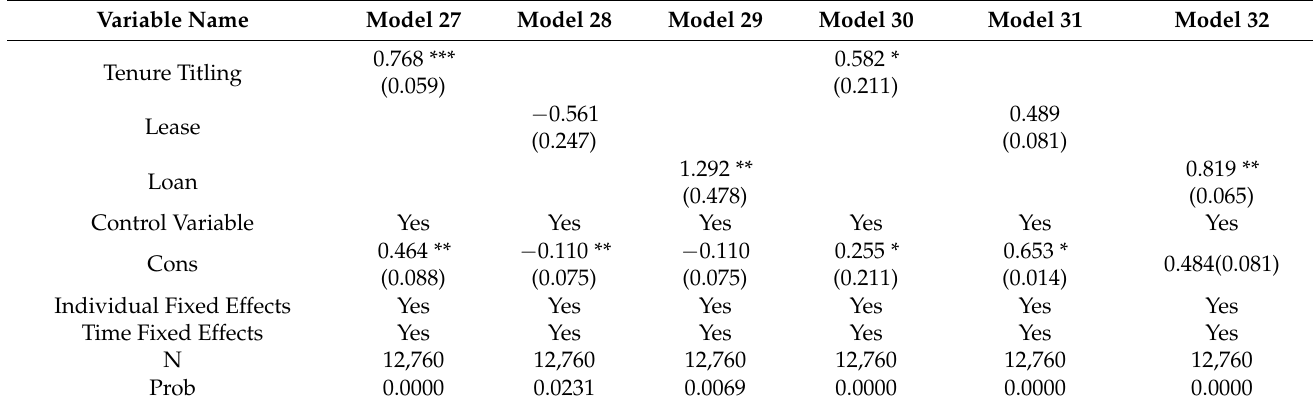
Table 6. Estimated results of the robustness tests of cash outlays and labor